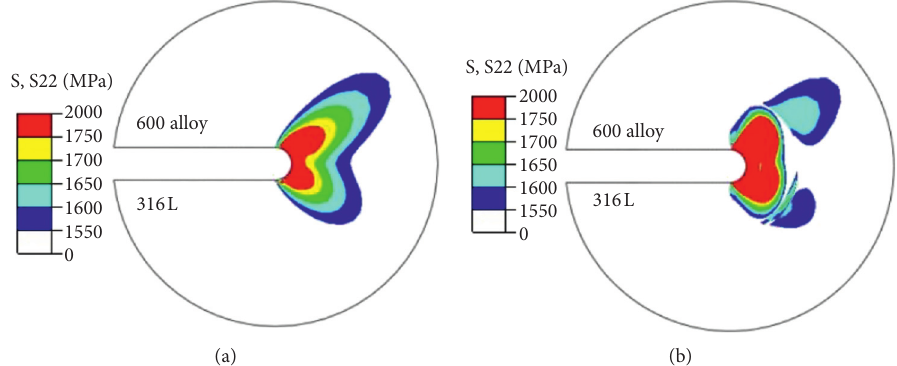
Figure 3: Comparison of tensile stress between the crack tip with and without hardening. (a) Without hardening. (b) With hardening.